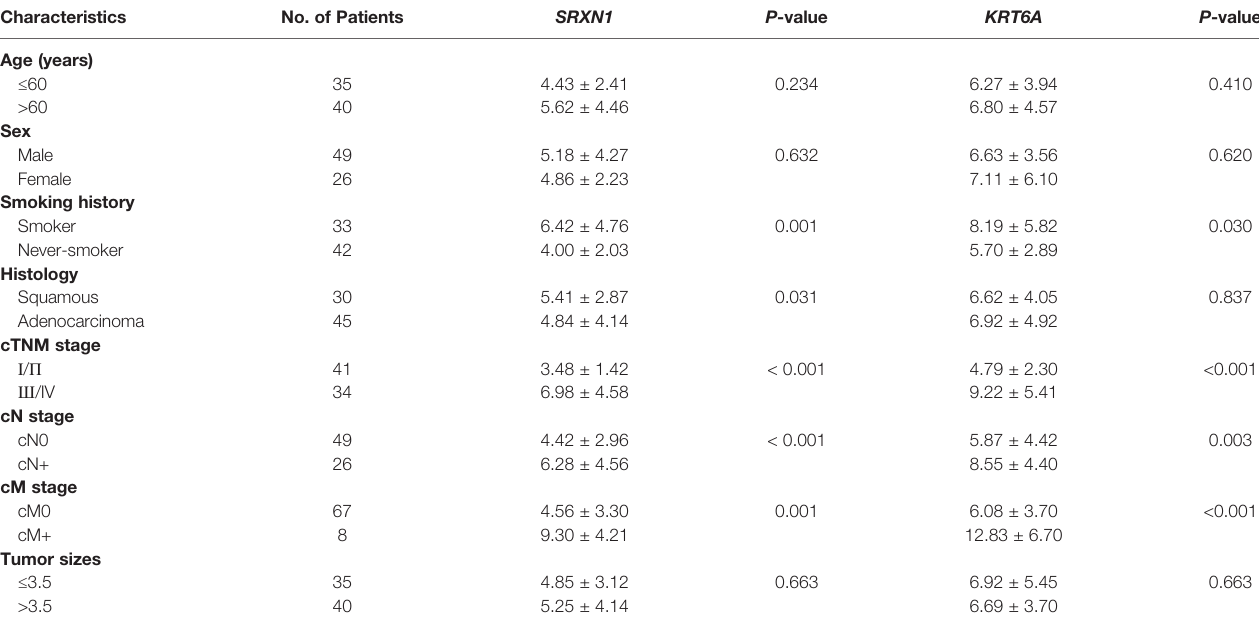
TABLE 4 | Non-parametric assessment of the correlations between clinicopathological factors and SRXN1 and KRT6A expression levels in 75 patients with non-small- cell lung cancer.